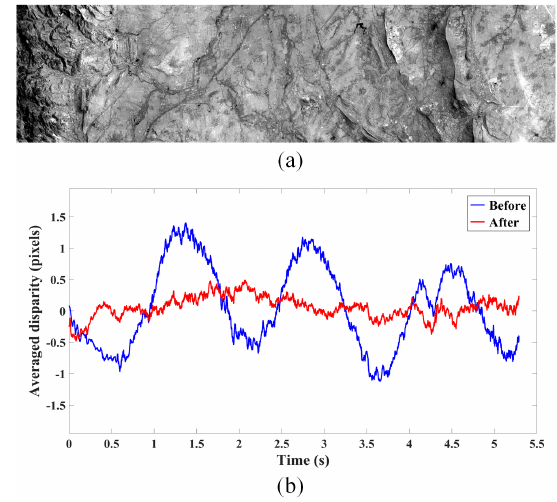
Figure 6. a) Reference panchromatic image; b) Averaged disparities between the reference image and the multispectral